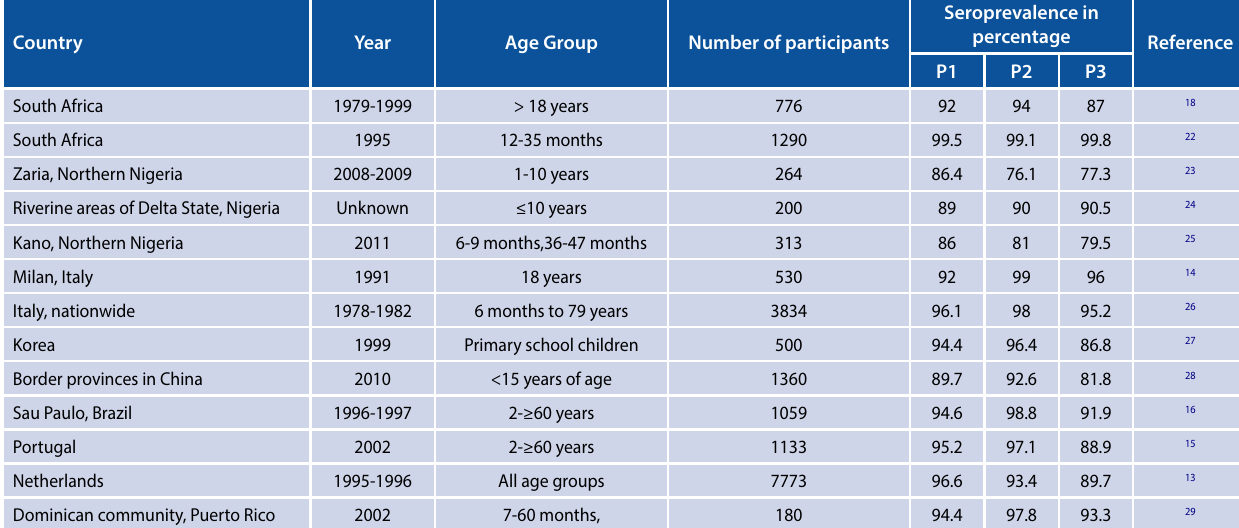
Table 2: Polio seroprevalence in various geographic areas